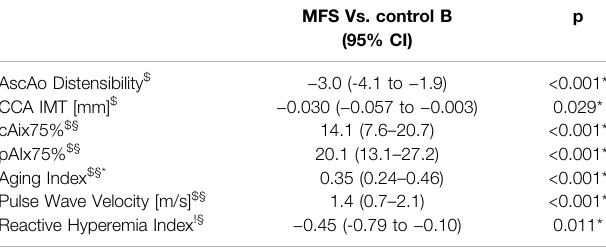
TABLE2| LinearregressionmodelcomparingvascularoutcomevariablesofMFS patients to Controls.